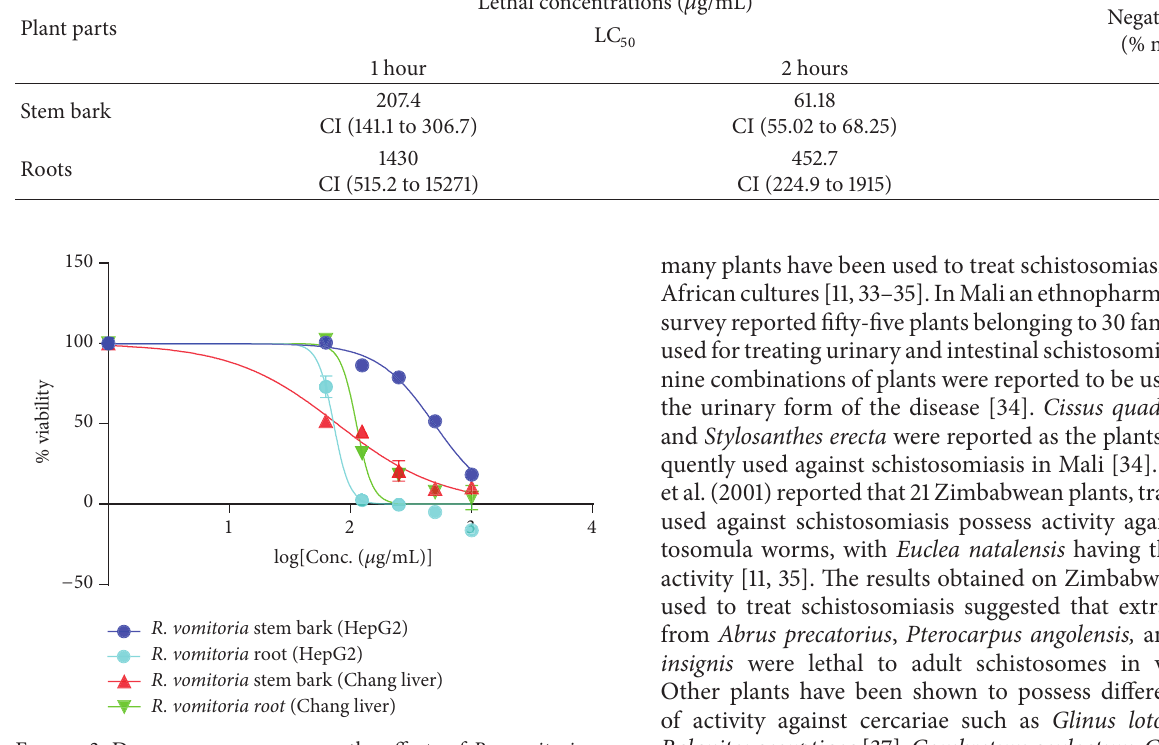
Figure 3: Dose-response curves on the effects of R. vomitoria on human HepG2 and Chang liver